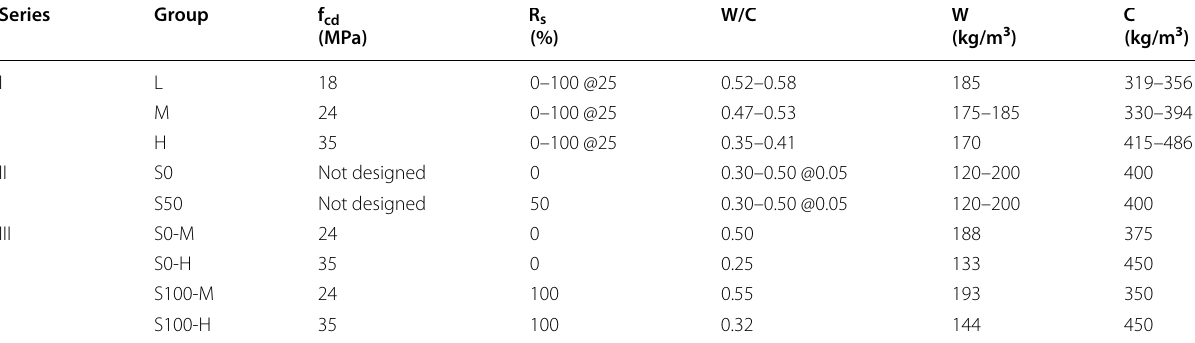
In the first series of mixtures, a marginally lower value of W / C was selected with the decrease in R s (the increase in lightweight fine aggregate content) to achieve f cd